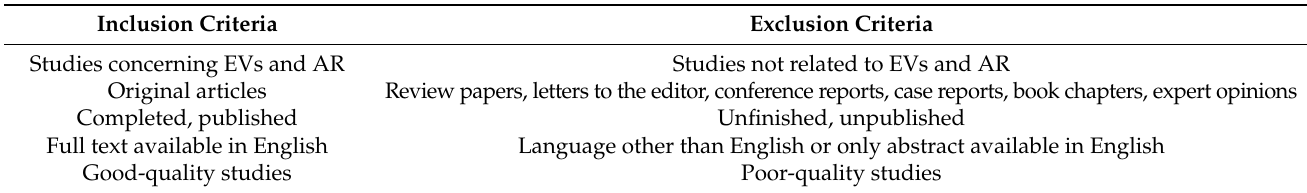
Table 1. Inclusion and exclusion criteria of included